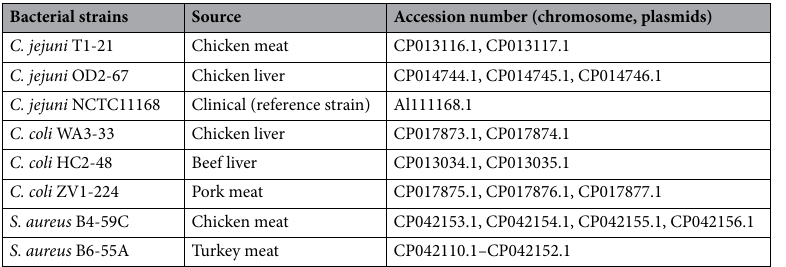
Table 1. Bacterial strains used in this study. All Campylobacter strains (except C. jejuni NCTC11168) and S. aureus strains were isolated and whole-genome sequenced in our laboratory 1–4,12,13,22,32–37